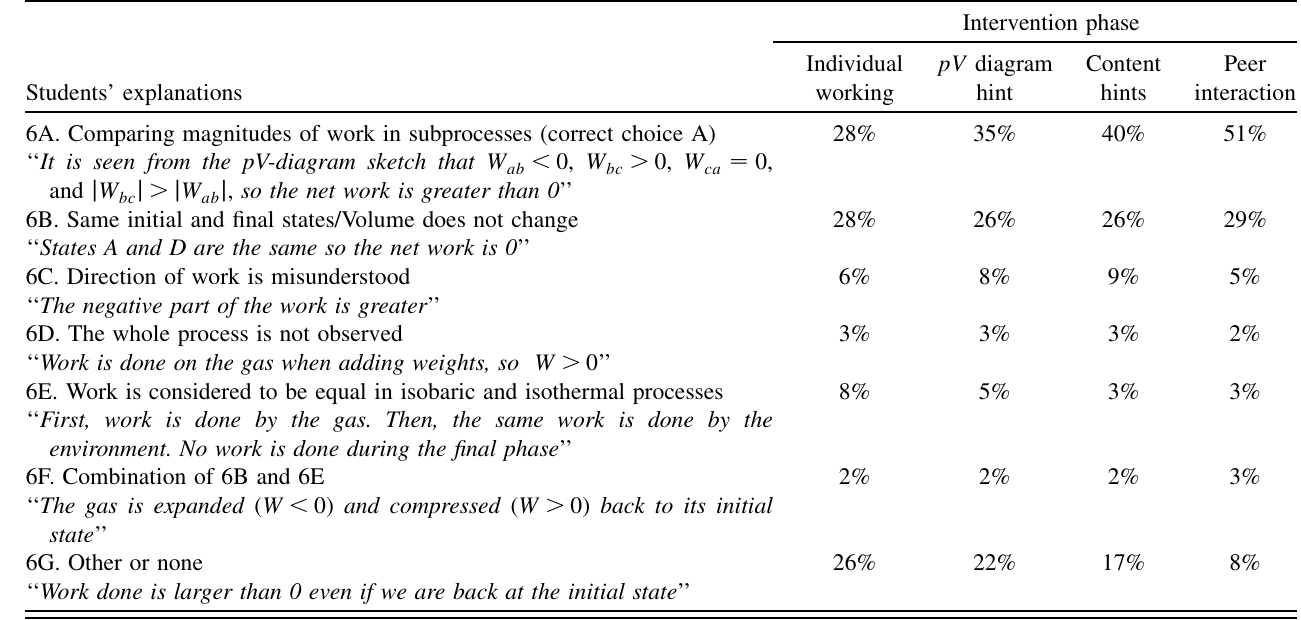
TABLE XII. Students’ categorized explanations regarding the net work done in a cyclic process. N ¼ 65 . A typical example from each category is presented after the category symbol and title in